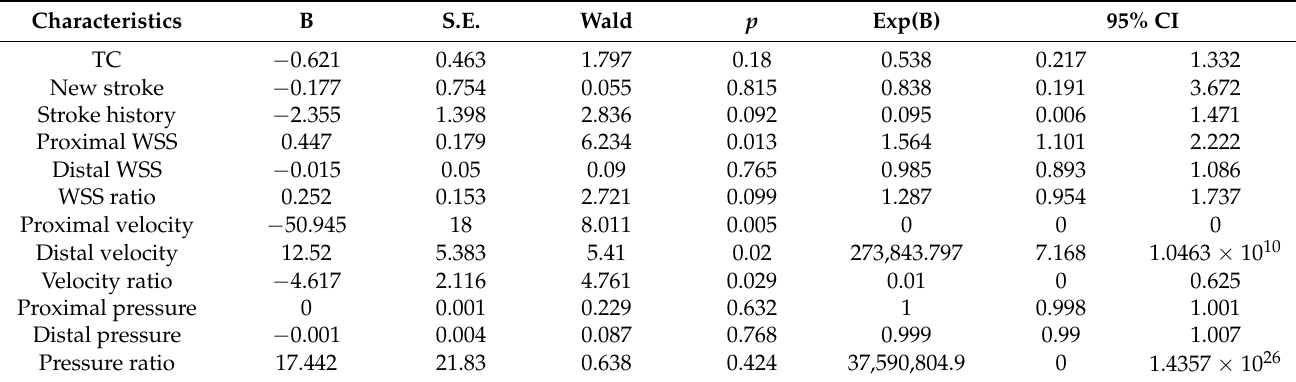
Table 2. Multivariate logistic regression of the fibrous cap